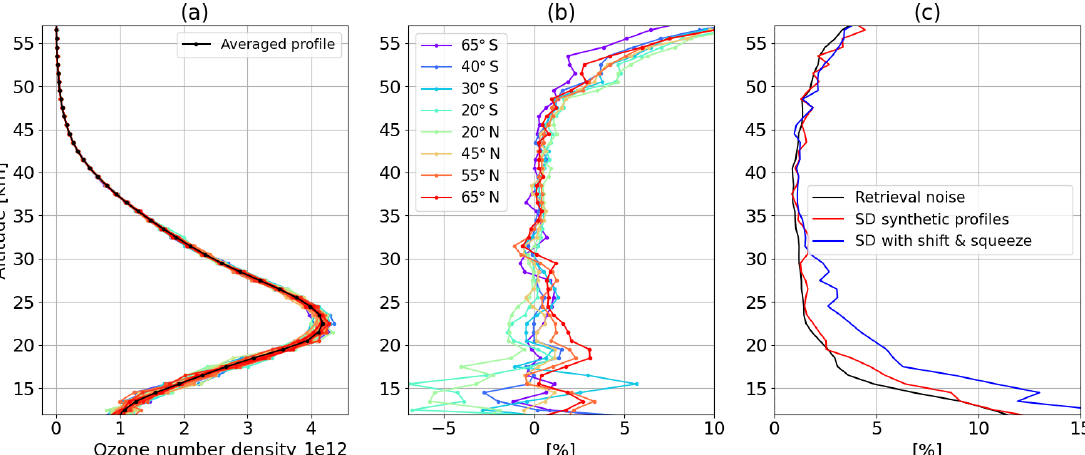
Figure 4. (a) All 50 retrieved unperturbed ozone profiles with their average in black. (b) Relative differences δ x, unpert at several latitudes. (c) Retrieval noise and standard deviation of the synthetic retrievals with and without shift and squeeze procedure.